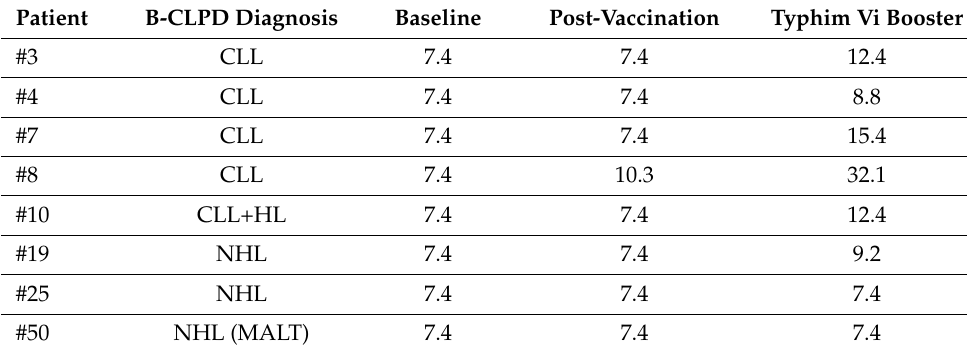
Table 6. Evaluation on humoral reconstitution after 12 months of IgRT by measuring Typhim Vi booster